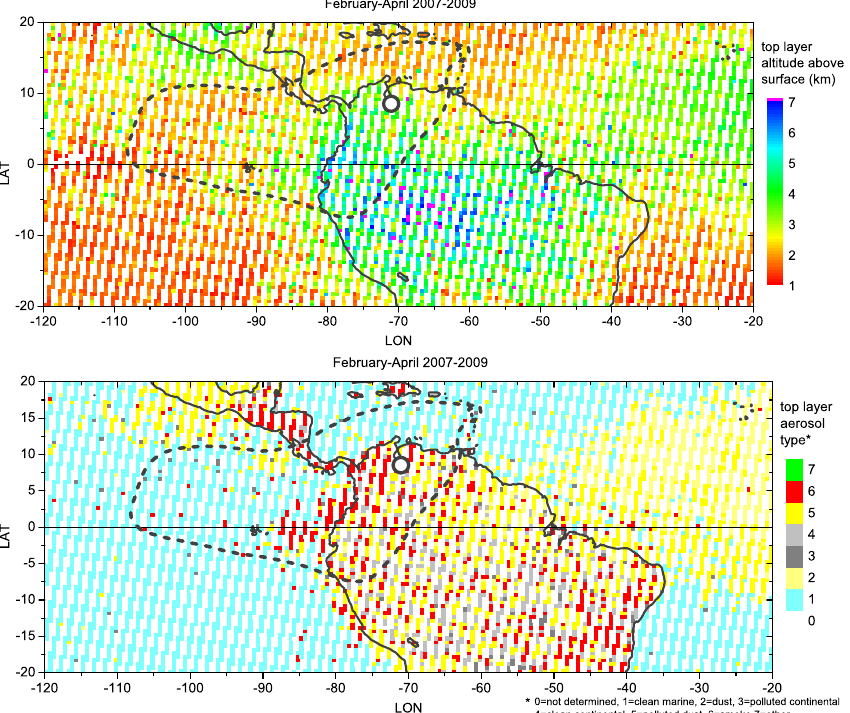
Fig. 7. CALIPSO satellite observations averaged for February–April for the years 2007–2009. Panel (a) shows the altitude above the surface of the upper most aerosol layer and panel (b) its dominating aerosol type (see Sect. 2.4 for details). Both parameters are retrieved from the LIDAR Level 2 5km aerosol layer product. The dashed line indicates the average area which is covered by 10 day forward trajectories within the same